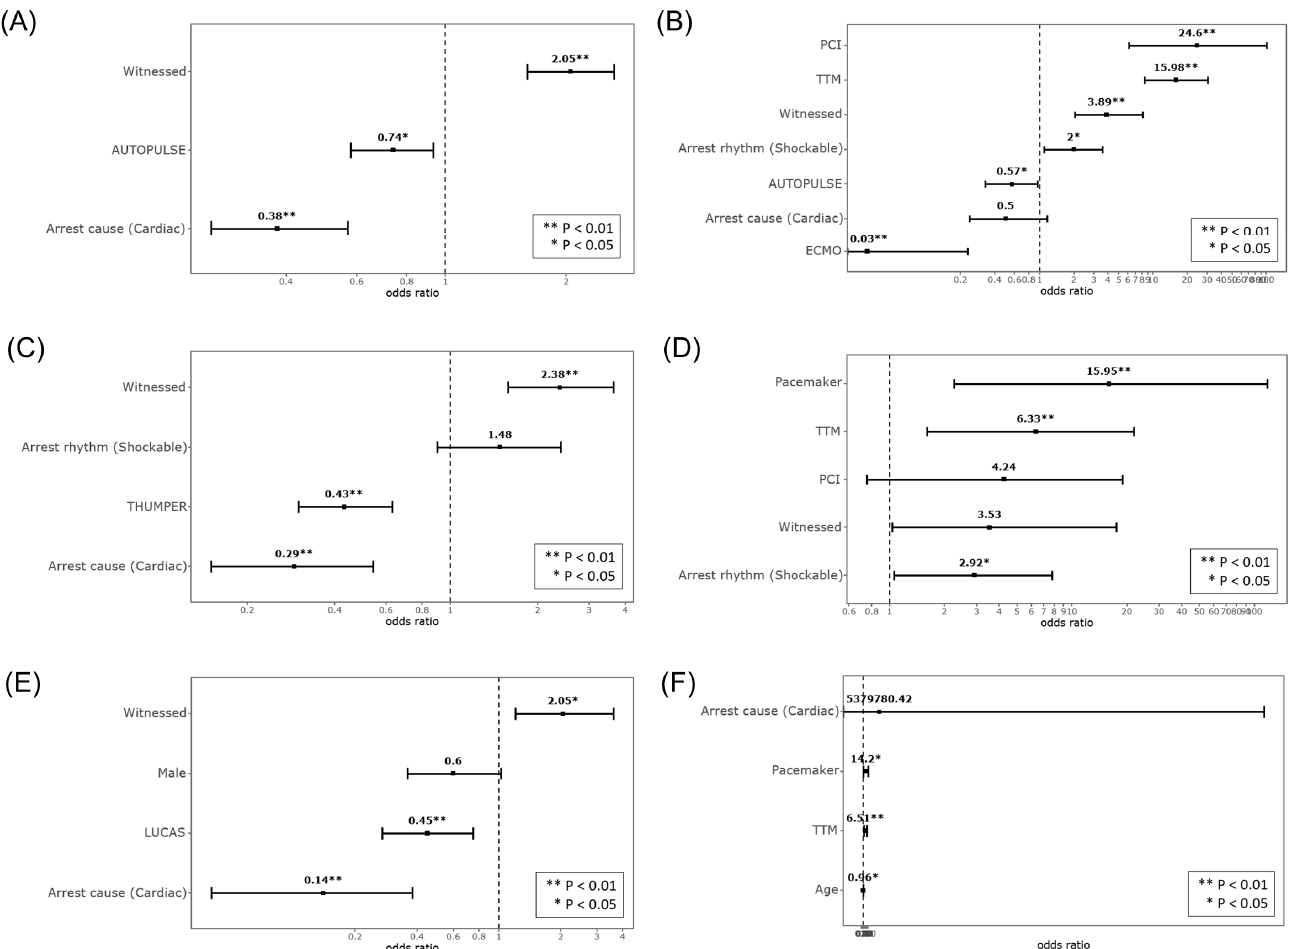
Figure 2. Forest plot of matched multivariate analysis for three types of mechanical CPR devices. ( A ) AutoPulse TM for sustained ROSC. ( B ) AutoPulse TM for survival at discharge. ( C ) Thumper TM for sustained ROSC. ( D ) Thumper TM for survival at discharge. ( E ) LUCAS TM for sustained ROSC. ( F ) LUCAS TM for survival at discharge. * was given a statistical significance of p < 0.05. ** was set at p < 0.01 indicating statistical